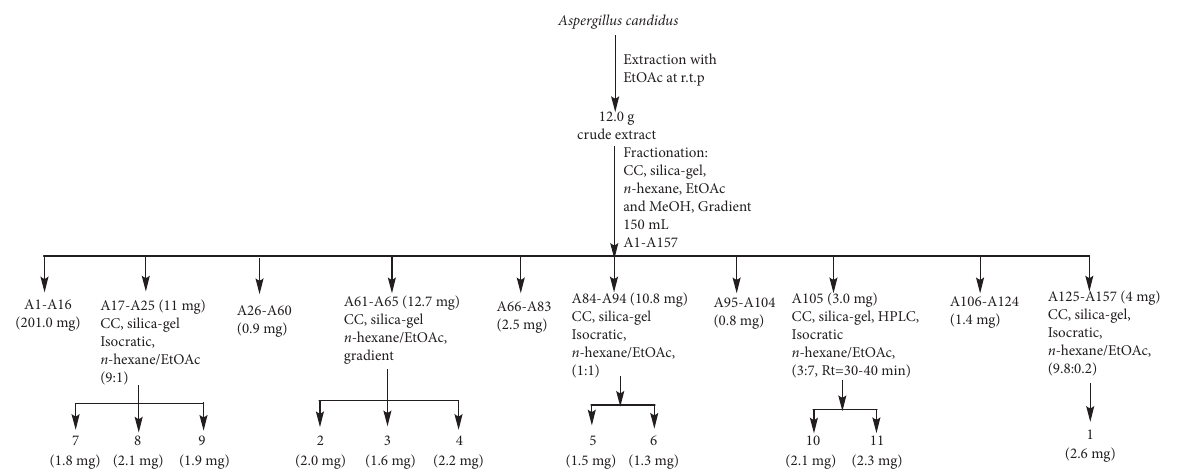
Scheme 1: Flow diagram for extraction and isolation of pure compounds from A. candidus .